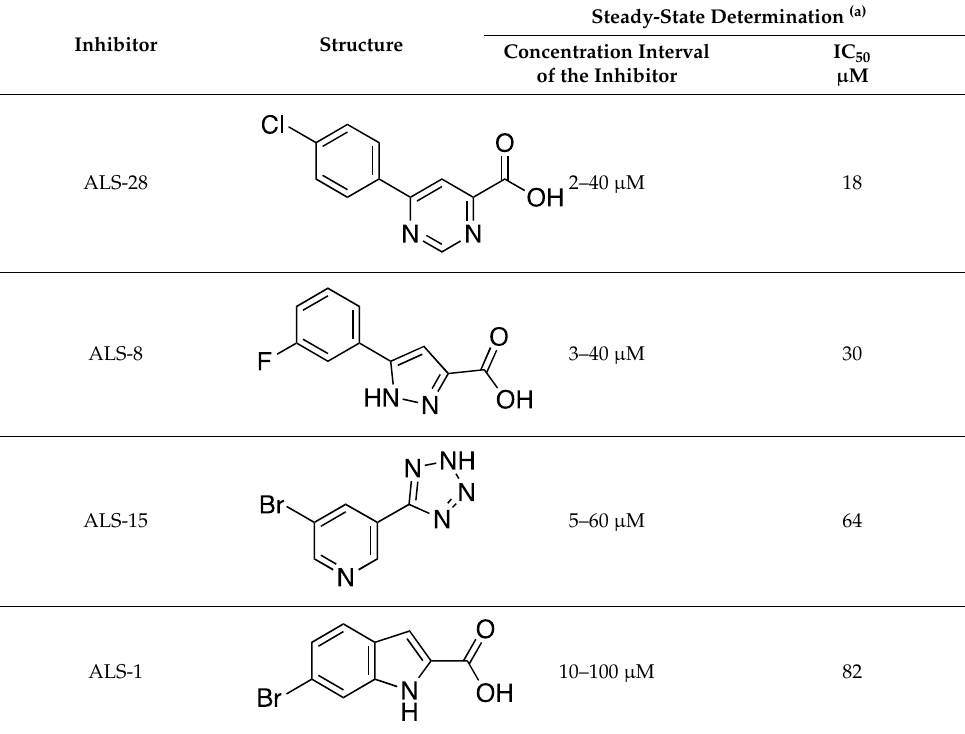
Figure 2. Dose-dependent inhibition profile of xanthine oxidase activity by ALS-28 , -8 , -15 or -1 . The activity of XO (12.5 mU) was measured in buffer A in the presence of 75 µM xanthine through the initial rate of uric acid formation in the presence of the indicated concentration of ALS-28 (panels ( A ) and ( E )), ALS-8 (panels ( B ) and ( F )), ALS-15 (panels ( C ) and ( G )) or ALS-1 (panels ( D ) and ( H )). The activity was expressed either as a percentage of that measured in the absence of inhibitor (panels ( A )–( D )) or as a natural logarithm of the ratio of residual activity (panels ( E )–( H )). Values were re- ported as the mean ± SE (panels ( A )–( D )); in the logarithmic representation of the data (panels ( E ) - ( H )), the correlation coefficients R ranged in the 0.966–0.995 interval. Other details are described in Materials and Methods. Table 1. Values of IC 50 obtained from inhibition profiles of structurally unrelated inhibitors of xanthine oxidase.